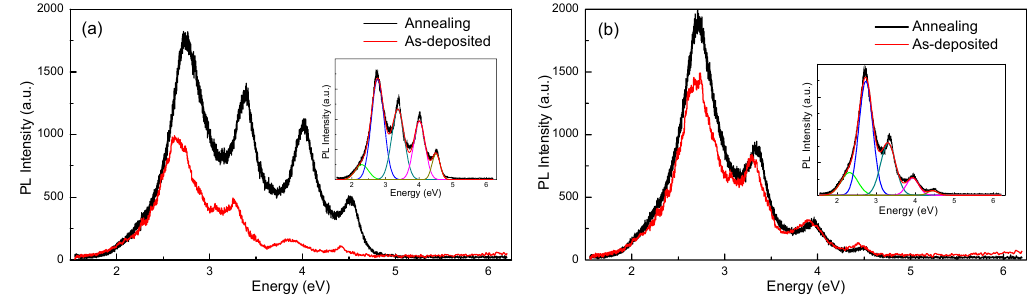
Figure 4. Photoluminescence (PL) spectra of ( a ) the EBD HfO 2 films and ( b ) the IAD HfO 2 films, excited by 193 nm laser irradiation. The insets are the multi-band fits.